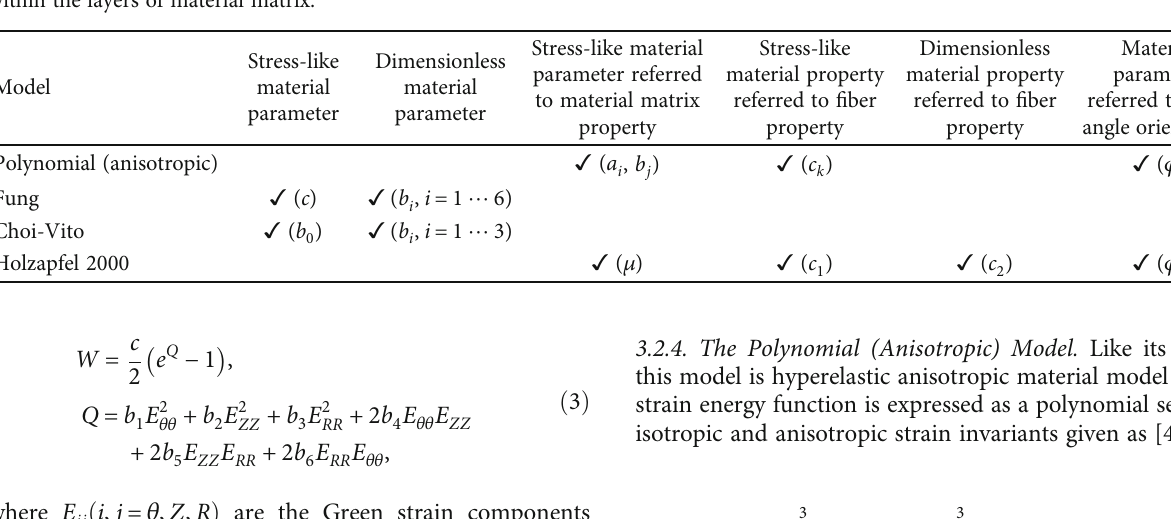
Table 1: The classi fi cation of the four hyperelastic anisotropic material models according to the material properties they represent. The Fung and Choi-Vito are classi fi ed as the models that model the soft tissue as layers of general material matrix, while the polynomial (anisotropic) and Holzapfel (2000) models are those that model the soft tissue as composite material with embedment of fi ber structures within the layers of material